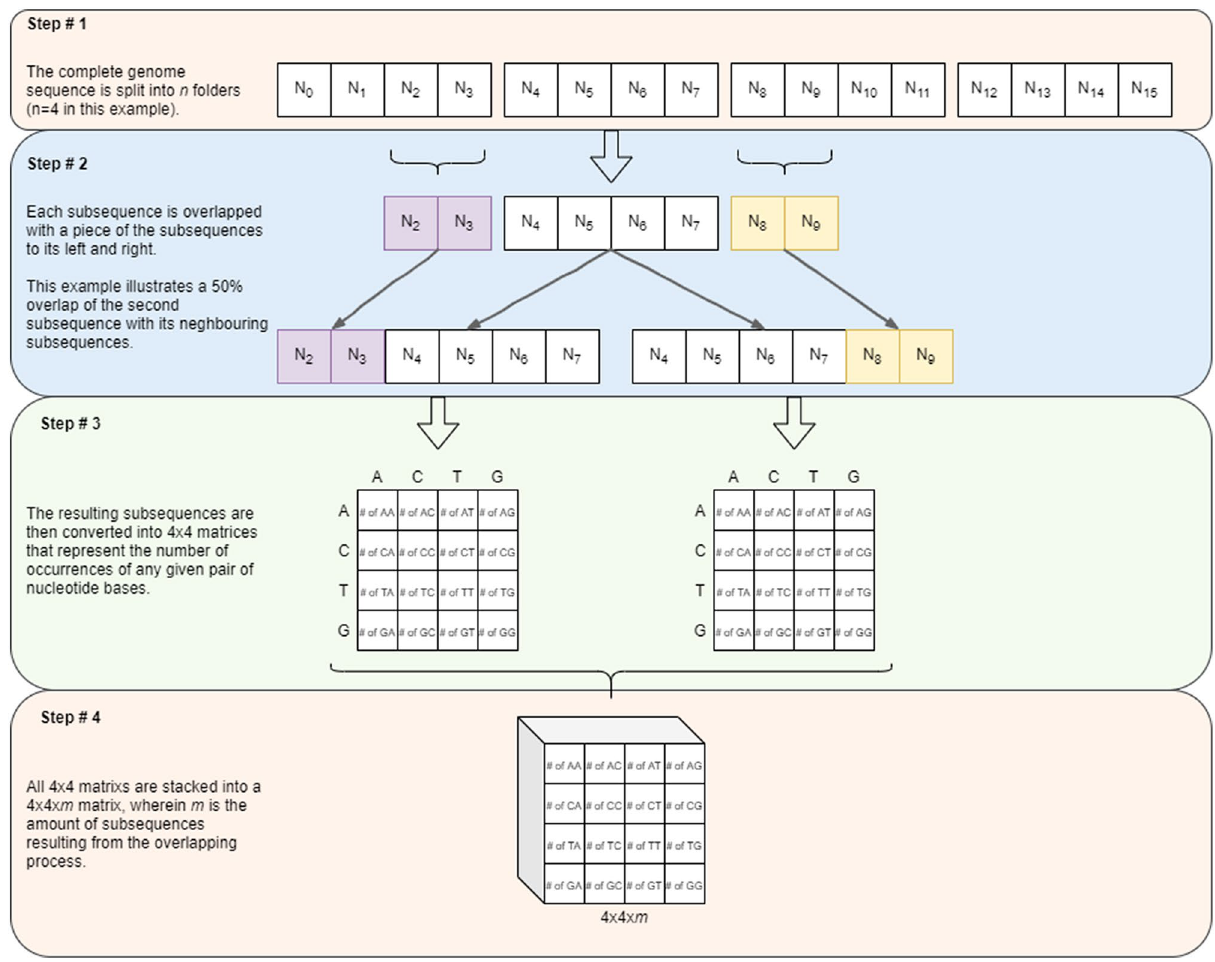
Figure 3. Steps of the proposed method: a new technique for representing genome sequences based on the analysis of the relationship between nitrogenous bases. The complete genome sequence is subdivided into n folders. Each sub-sequence is combined with a piece of its neighbors, generating two new sequences. These smaller sequences are represented by co-occurrence matrices, considering the occurrence of each of the nitrogenous bases, and the relationship between bases and their immediate neighbors. In the next step, theses matrices are stacked together as a volume. Finally, this set in concatenated, forming attribute vectors, which are a high-level vectorial representation of the original